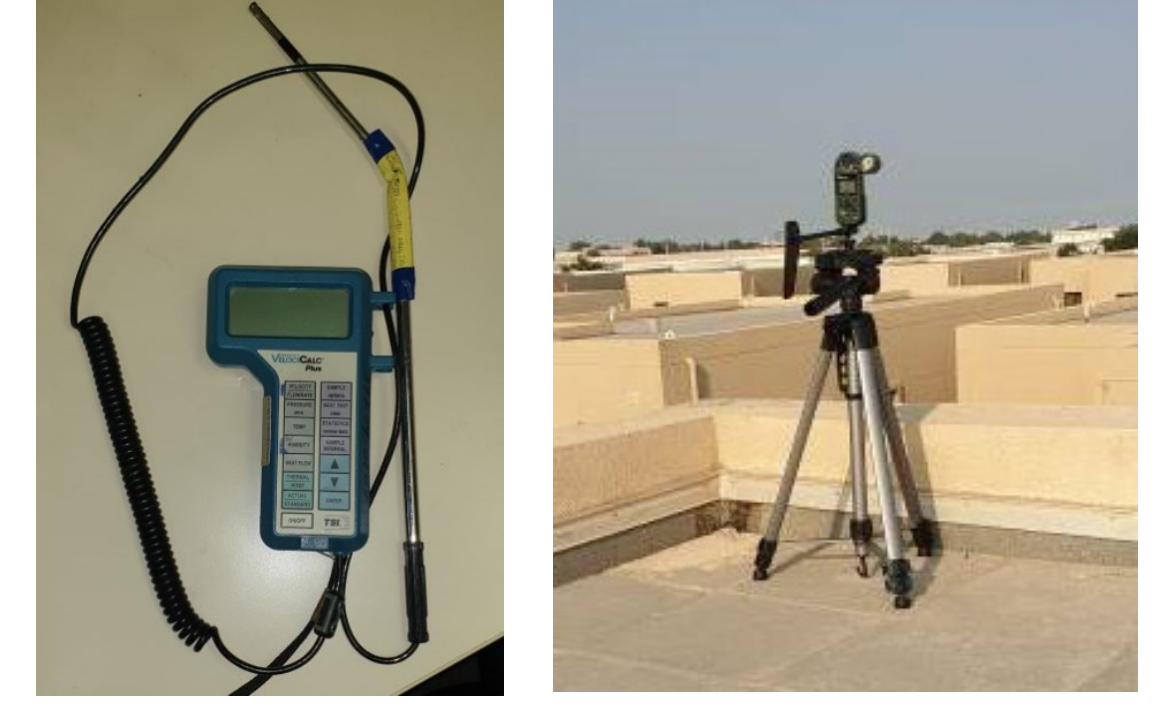
Figure 10. Used pressure differential equipment and weather station.